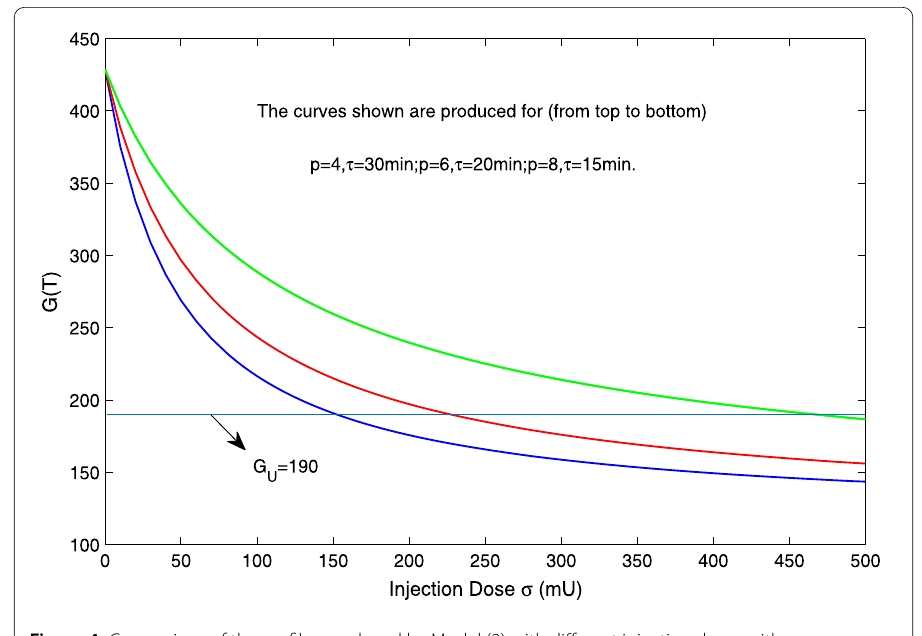
Figure 4 Comparison of the profiles produced by Model (2) with different injection doses with G